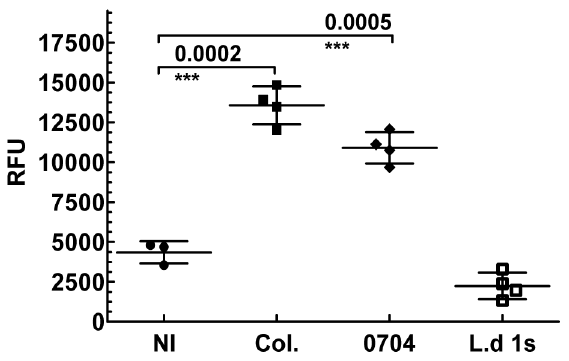
Figure 5. Apt-L44 ELA assay can detect mice infected with T. cruzi . Plasma, at 1:200 dilution, from groups of mice infected either, the T. cruzi Colombiana (Col., n=4) or, the 0704 (n=4) strain, was coated on a polystyrene 96 well plate and ELA assay was performed using biotinylated Apt-L44. Signal generated, relative fluorescence units (RFU), are plotted on the Y-axis and each point represents the mean of duplicate values from individual mice. Group means and standard deviations are shown and statistical significance, compared with the non-infected group (NI, n=4), determined using the unpaired t-test with Welch correction with a 95% confidence intravel. Biotinylated Apt- L44 showed significant binding to plasma from mice infected with either the Colombiana or the 0704 strains of T. cruzi and showed no binding with plasma from L. donovani infected mice (L.d 1 s, n=4).